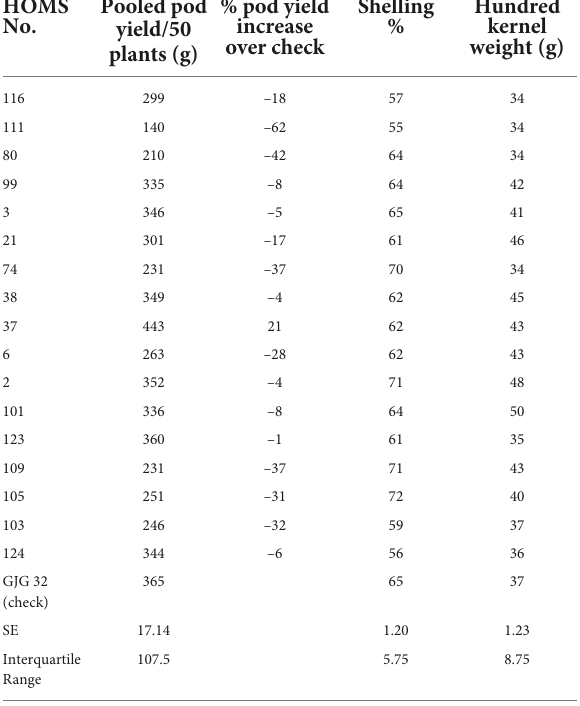
TABLE 5 Pooled pod yield over two seasons of Spanish bunch (SB) high oleic breeding lines and percent increase of pod yield over check. HOMS No.